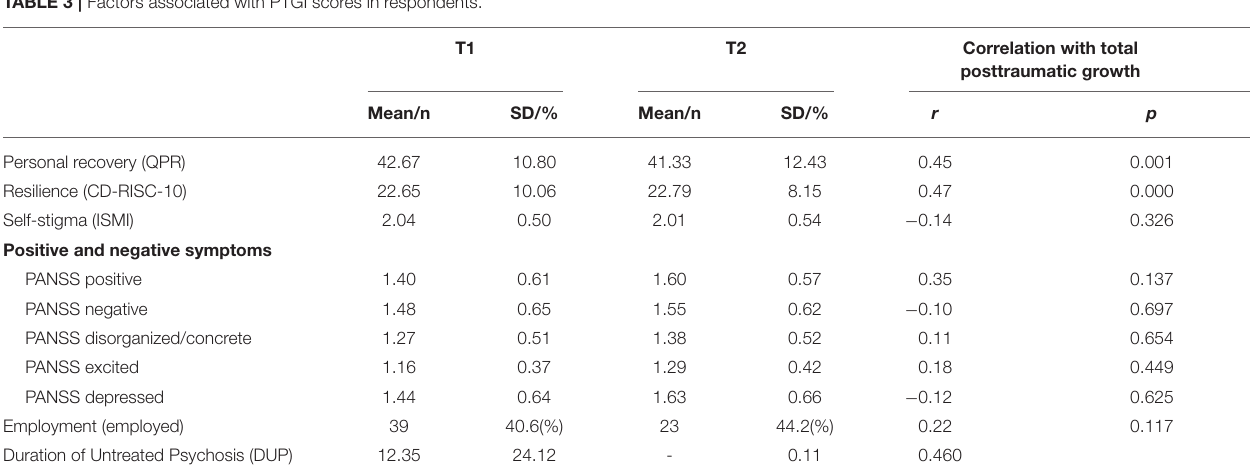
posttraumatic growth